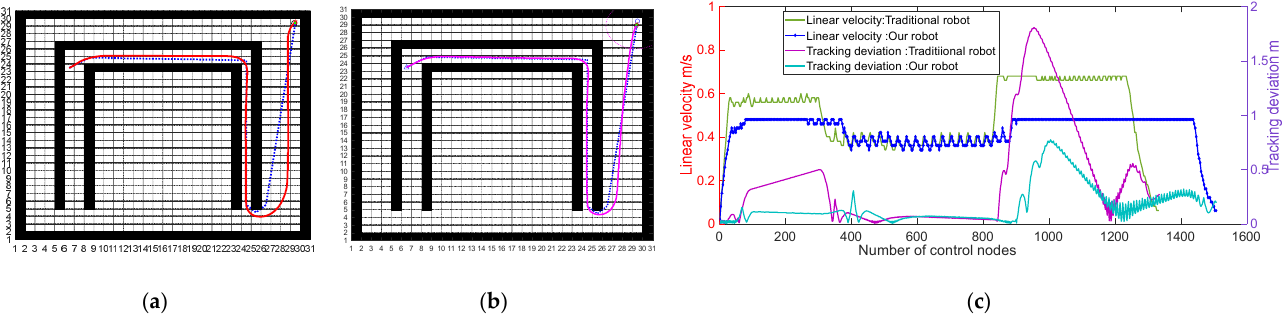
Figure 17. Map 4’s experimental results. ( a ) Traditional robot. ( b ) Our robot. ( c ) Two-coordinate plot of linear velocity and tracking deviation.